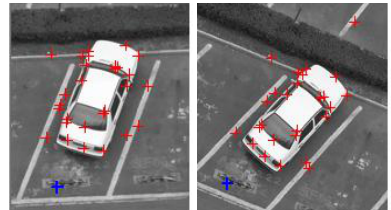
Figure 5 (a) matching result by SIFT algorithm, red cross for corresponding point, blue cross for one pair of corresponding point